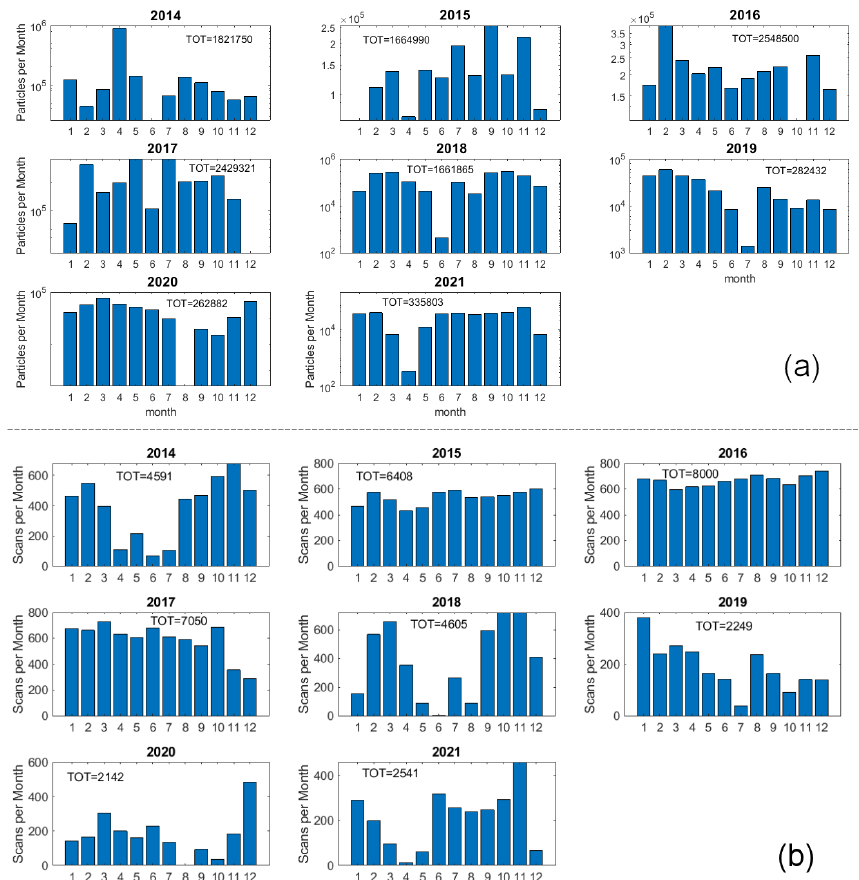
Figure 18. Statistics per month for the years 2014 to 2021. (a) Ice particle counts per month (total counts per year are also reported). (b) Number of scans per month (total number per year is also